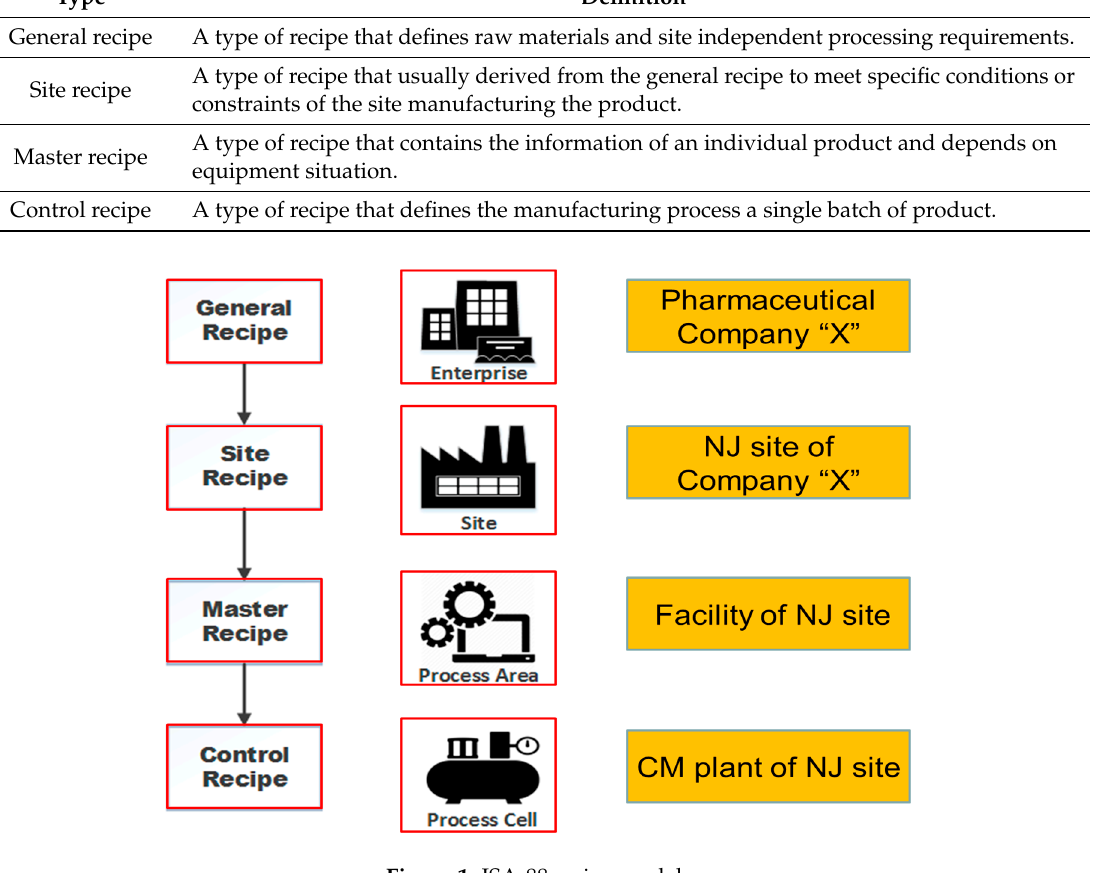
Figure 1. ISA-88 recipe model.